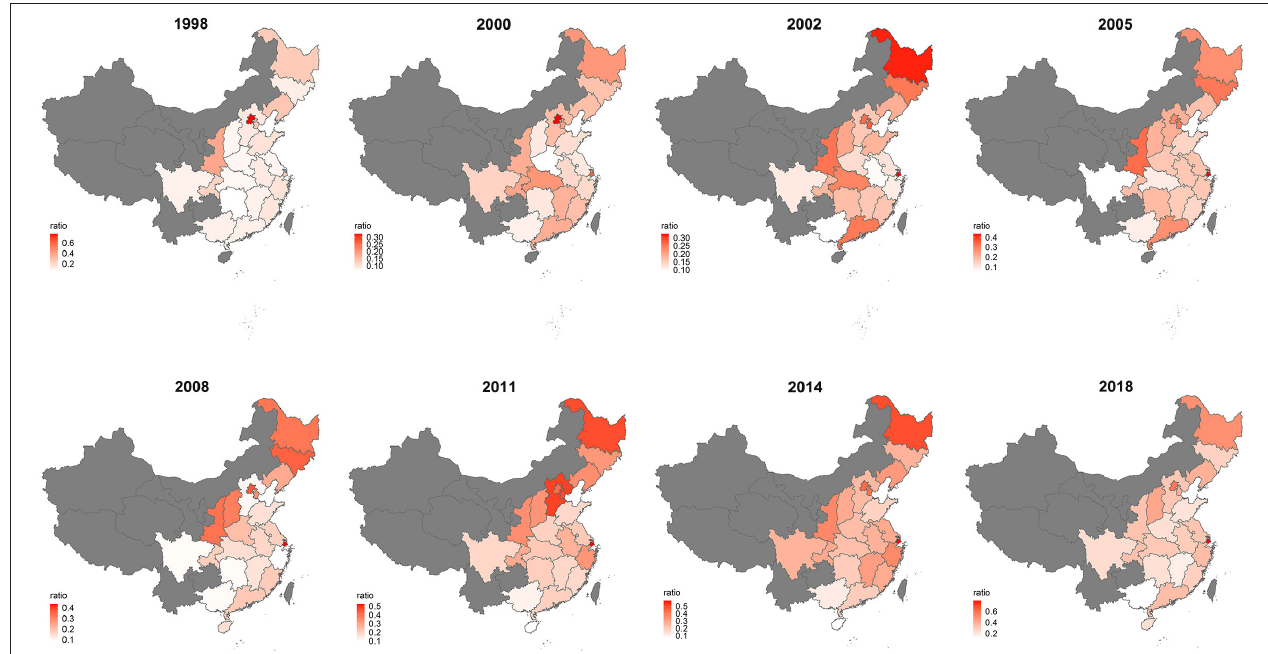
FIGURE 3 | The distribution of prevalence in different provinces for the survey of eight waves.